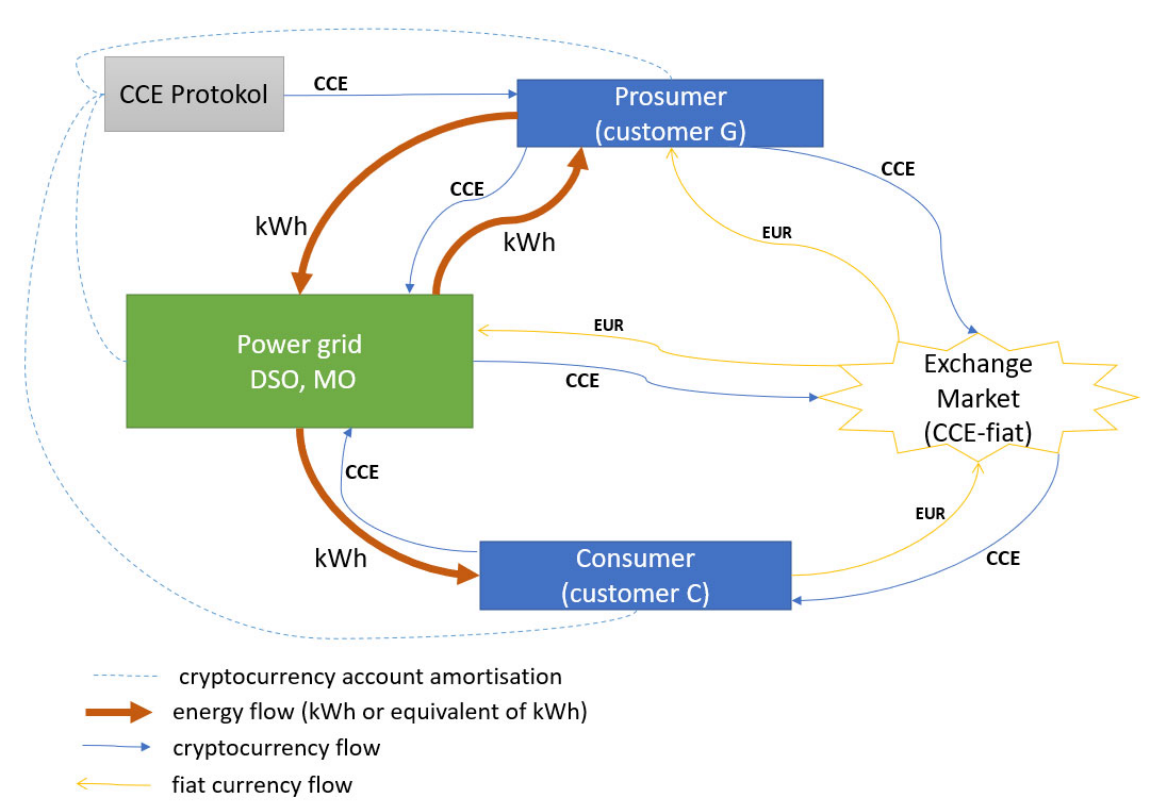
Figure 6. Functional diagram of CCE system for net metering.